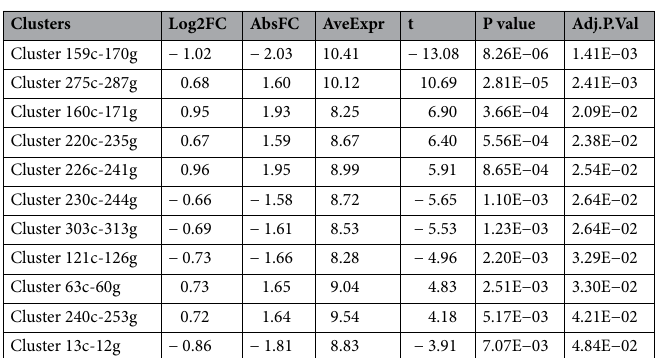
Table 3. Differentially expressed piRNA clusters. Pairwise comparison between generation F 1 from exposed (8.7 mGy/h γ-radiation) (F 1 -γ) and control parents (F 1 -C).